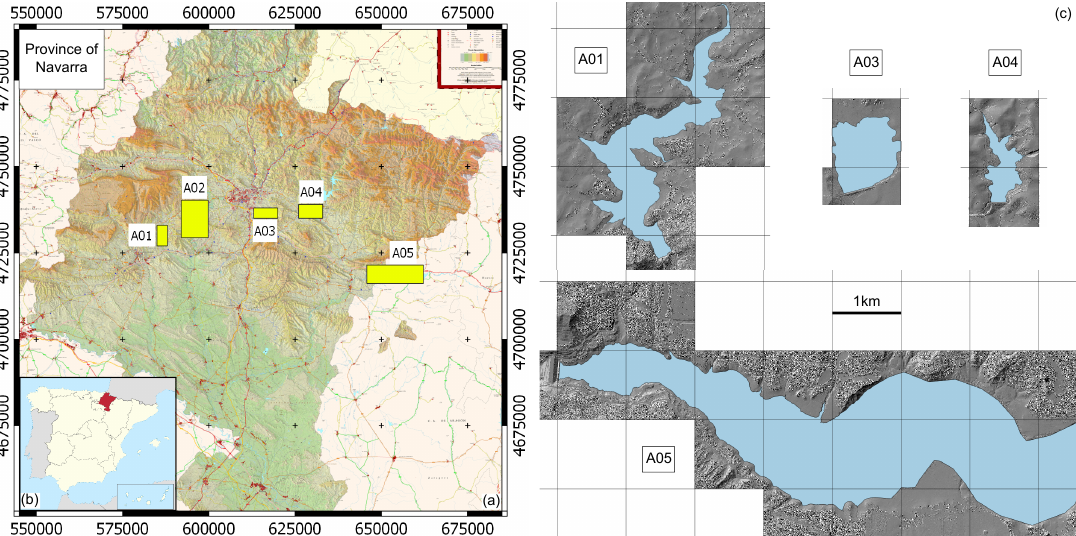
Figure 3. Single Photon LiDAR area Navarra, Northern Spain; ( a ) foreground: base map of Navarra, background: OpenStreetMap, yellow boxes: selected reservoirs (A01-05), coordinate frame: WGS84/UTM 30N, units = meters; ( b ) overview map of Spain; ( c ) detailed terrain relief maps of reservoir areas A01, A03-05; coordinate grids: